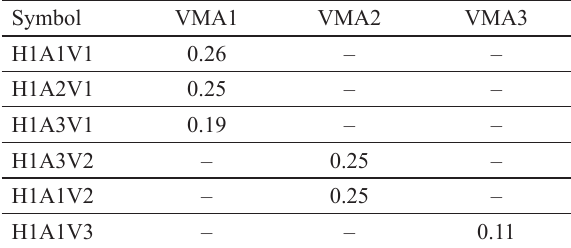
Table 9. The dosage of VMA by weight of total binder,